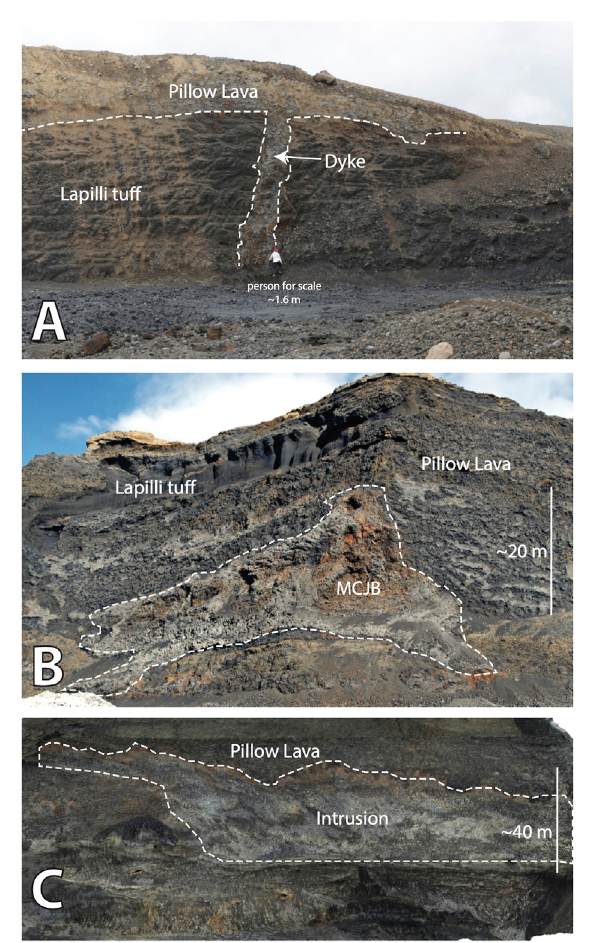
FIGURE 5 Field images showing intrusions. (A) Dyke feeding overlying pillow lavas, Undirhliðar quarry. Personfor scale. (B) Irregular intrusion into pillow lavas, Vatnsskarð quarry. Maximum vertical dimension